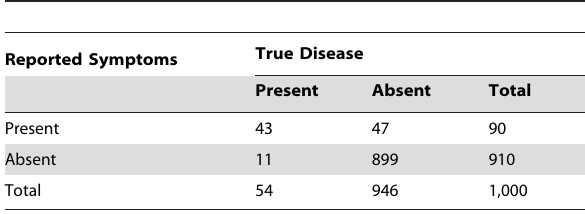
Table 7. Distribution of cases of ‘‘true pneumonia’’ according to caregiver report of ‘‘suspected pneumonia’’ (test) and true disease status when test sensitivity is 80% and specificity is 95% with an eight-week recall